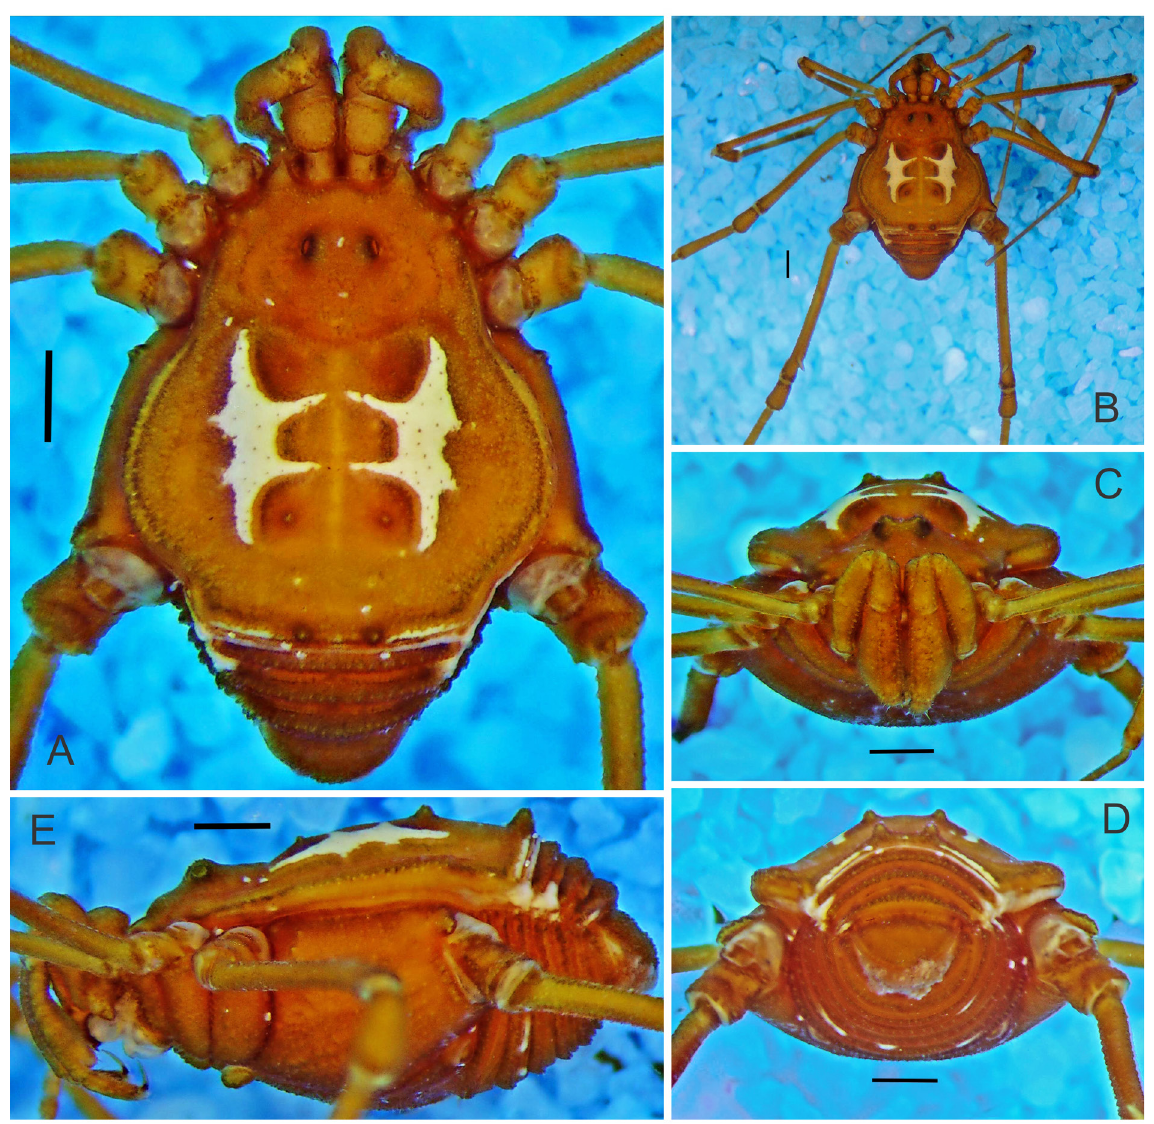
Fig. 11. Eulibitia helena sp. nov., ♂, holotype (IAvH 45), habitus. A . Dorsal view. B . Panoramic, dorsal view. C . Frontal view. D . Posterior view. E . Left lateral view. Scale bars: 1